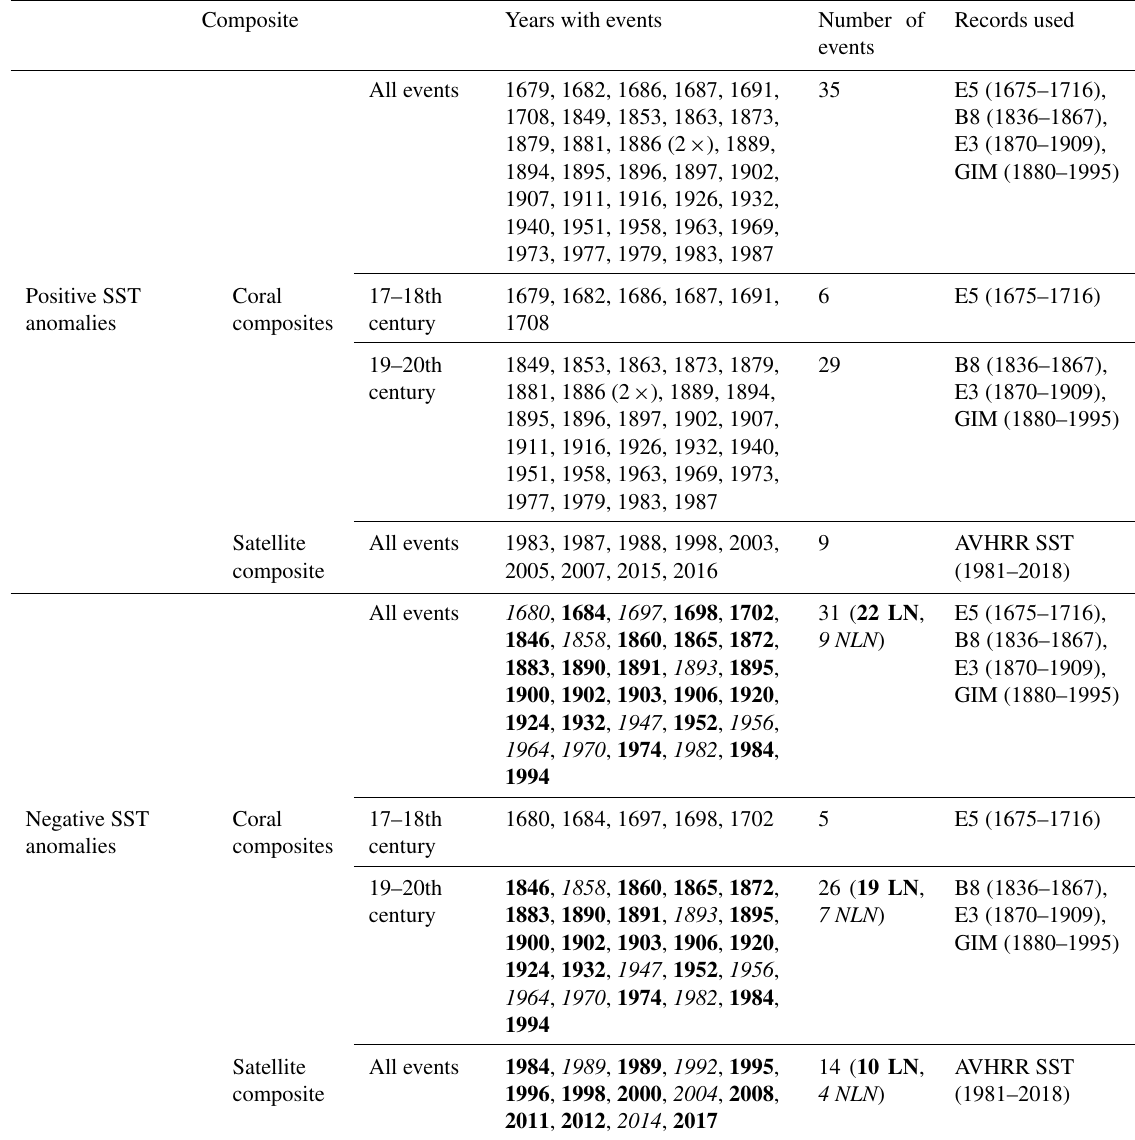
Table 4. Positive (El Niño events) and negative (La Niña events, LN, shown using bold font; and non-La Niña events, NLN, shown using italic font) SST anomaly events picked for generating coral and satellite composite records shown in Figs. 7 and